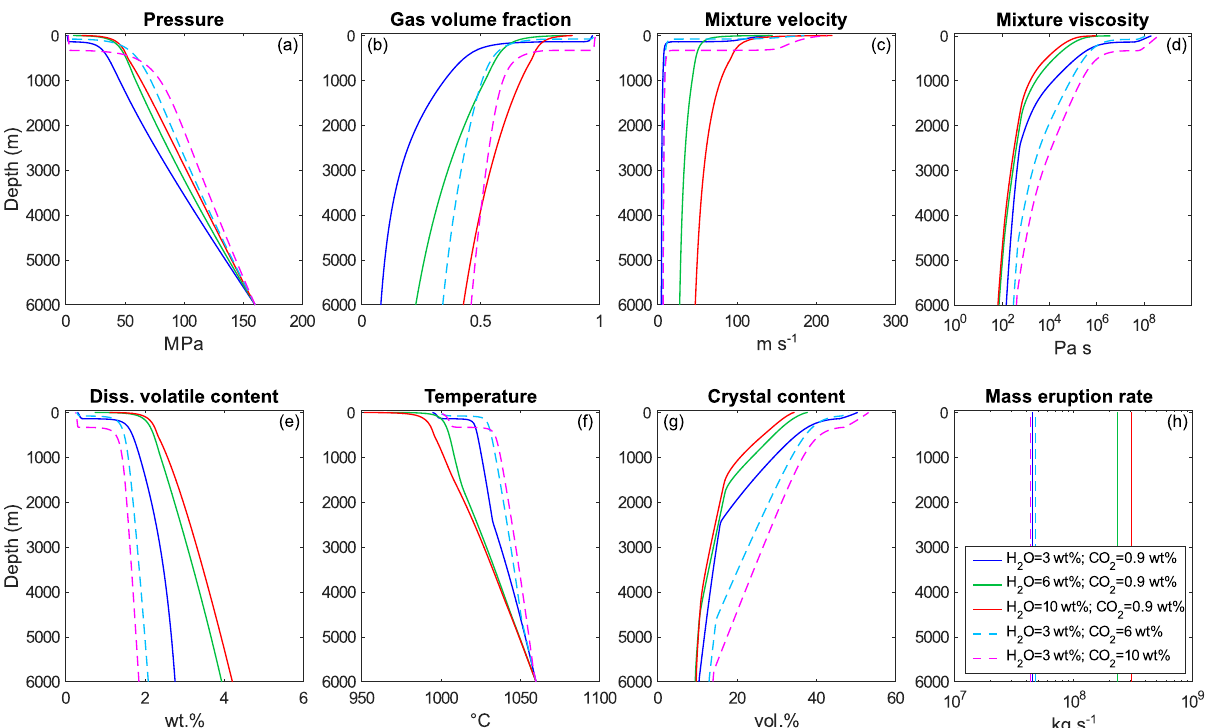
Fig. 2 Comparison of the numerical solutions for the reference and excess volatile simulations. Evolution of ( a ) pressure, ( b ) exsolved gas volume fraction, ( c ) mixture velocity, ( d ) mixture viscosity, ( e ) dissolved volatile content, ( f ) temperature, ( g ) total crystal content and ( h ) mass eruption rate (MER) along the conduit obtained for the Etna 122 BCE reference case (blue solid lines) and for the excess H 2 O (green and red solid lines) and CO 2 (cyan and magenta dashed lines) case. Crystal content indicates the sum of phenocrysts and microlites content, where the phenocryst content is assumed constant throughout the conduit (equal to the initial crystal content), and only microlites are crystallising during